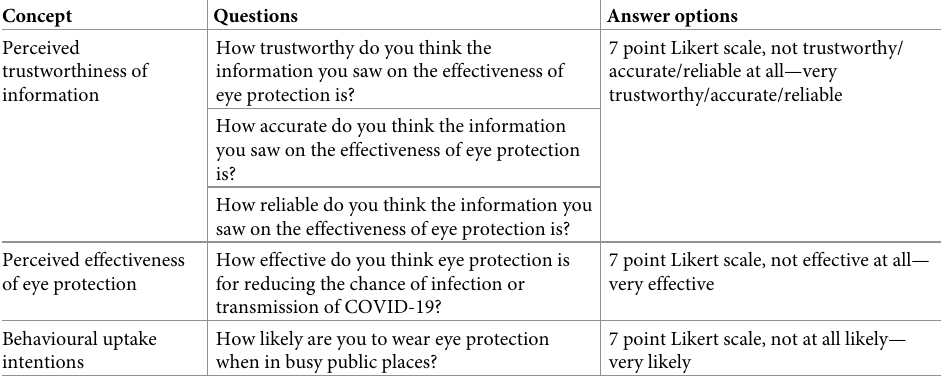
Table 1. Overview of dependent measures for Experiments 1 and